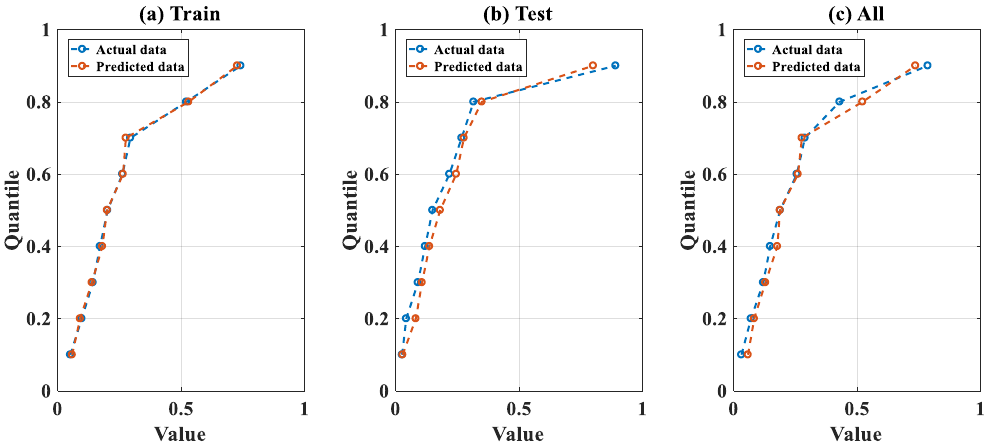
Figure 9. Comparison between actual and predicted data at different quantile levels of the